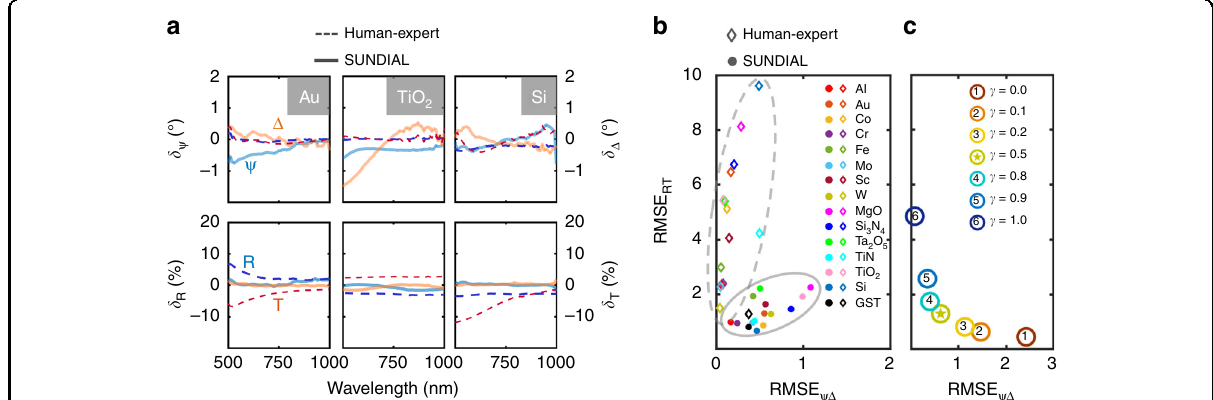
Fig. 4 Comparison of SUNDIAL with the traditional fi tting technique. a Residual on three typical materials of SUNDIAL (solid lines) and the traditional fi tting technique (dashed lines). Both methods fi t ( Ψ , Δ ) very well, while the traditional fi tting method shows a signi fi cant error in fi tting ( R , T ). b RMSE of the compared methods on more tested materials. SUNDIAL (solid dots) signi fi cantly outperformed the traditional fi tting method (empty diamonds) in terms of overall accuracy. RMSE ΨΔ = RMSE Ψ + RMSE Δ , and RMSE RT = RMSE R + RMSE T . c Effect of γ . Experiments with different γ values are conducted, and the RMSEs are shown here. Tungsten (W) is used here as an